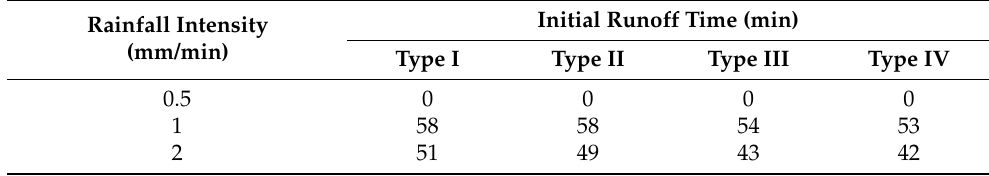
Table 2. Initial runoff time of each permeable pavement under different rainfall